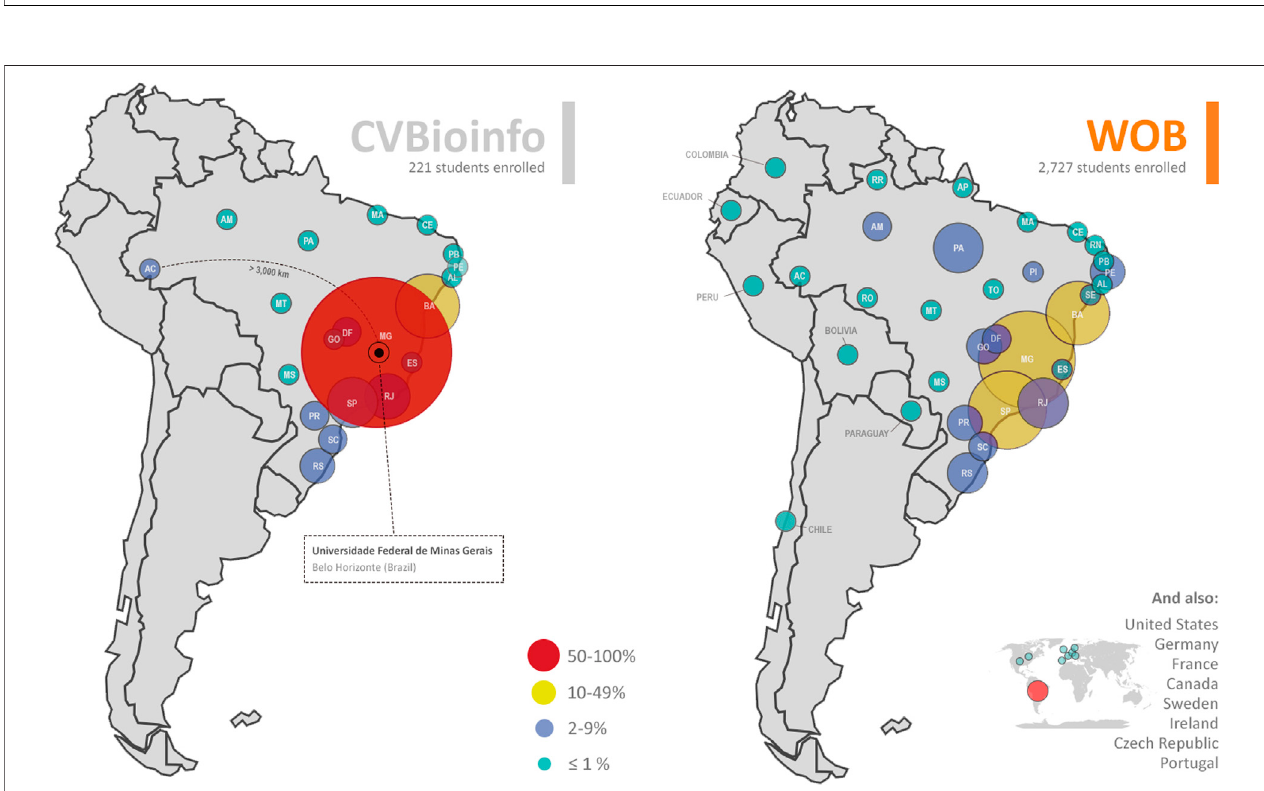
FIGURE 5 | Comparison between the percentage of registrants in the face-to-face event called CVBioinfo 2020 (left) and in the online event, named WOB 2020 (right) .CVBioinfo-SummerCourseofBioinformatics2020(n (cid:1) 221)andWOB – WorkshopOnlineonBioinformatics2020(n (cid:1) 2,727).RegistrationsgroupedbyBrazilian states are shown on the bar plot in the center. Figure generated using Python (Plotly and pandas libraries), Microsoft Excel, and Adobe Photoshop.